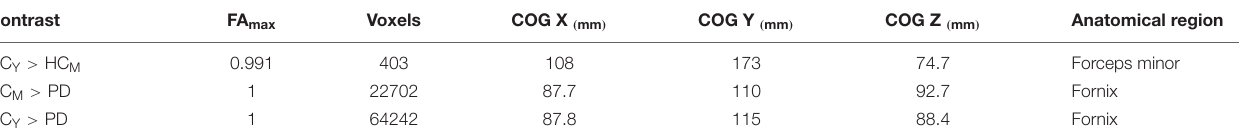
TABLE 2 | Details of significant